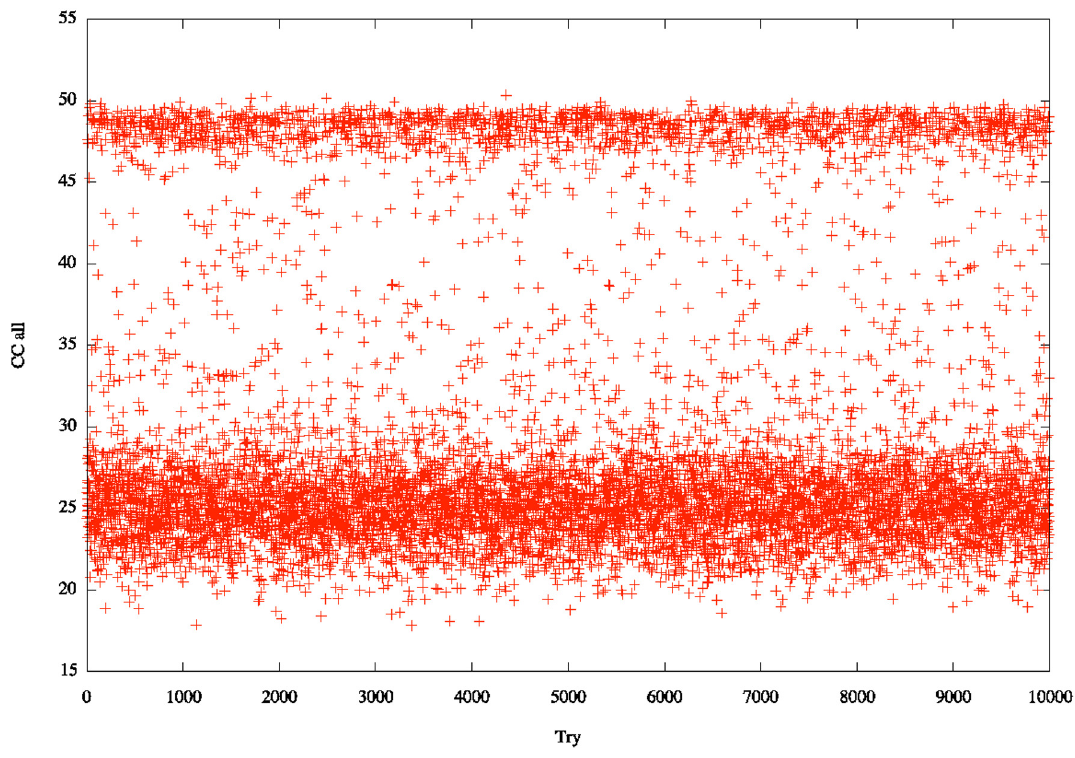
Figure 6. Scatter plot of CCall calculated by SHELXD versus try number for 2’-thio